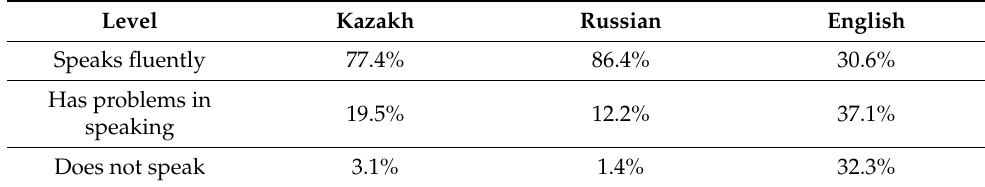
Table 2. The respondents’ language proficiency